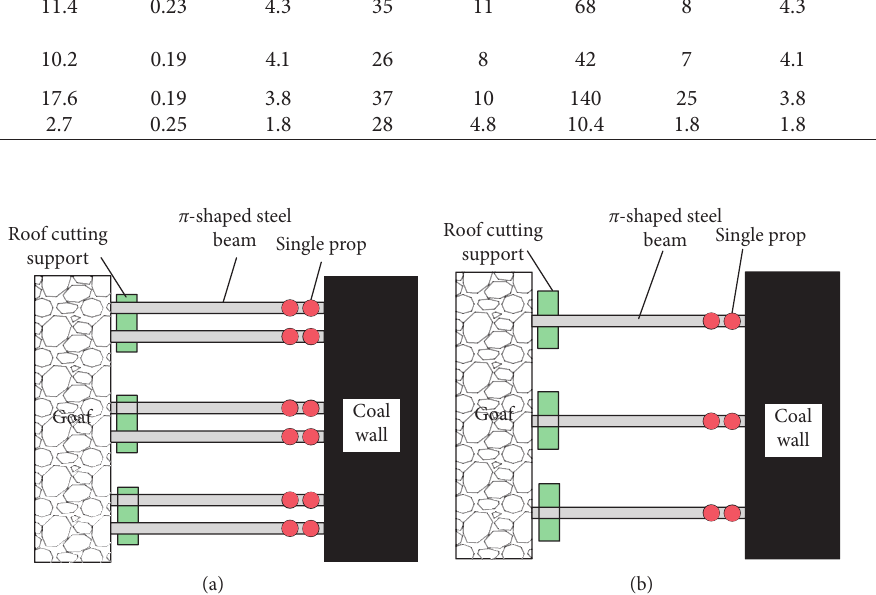
Figure 8: Change in temporary supports: (a) the original temporary support; (b) the changed temporary